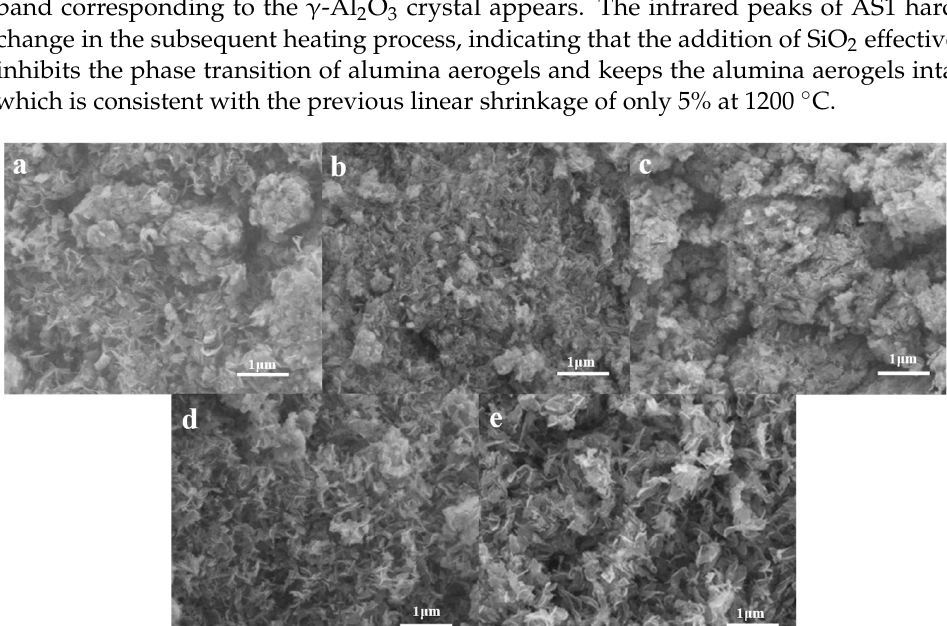
Figure 3. Scanning electron microscopy (SEM) images of AS0 after heat treatment from 20 to 1200